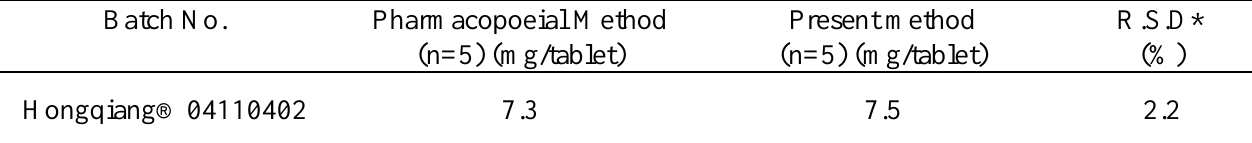
Table 3. Determination results of meloxicam in tablets.